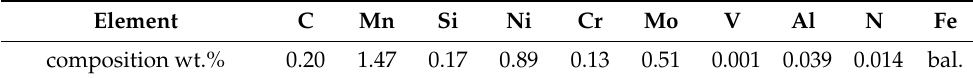
Table 3. Chemical composition of SA508 Gr.3 steel